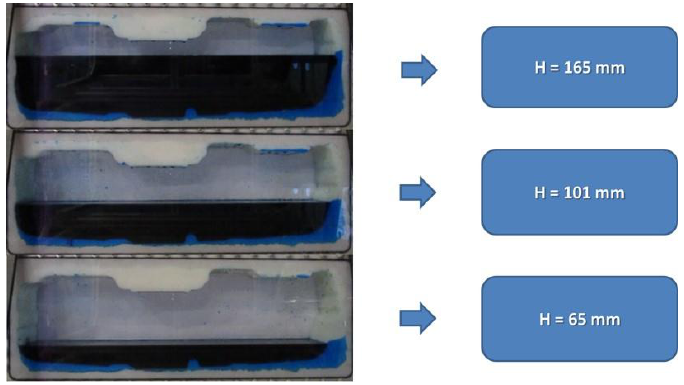
Figure 2. Three tested water free surfaces.